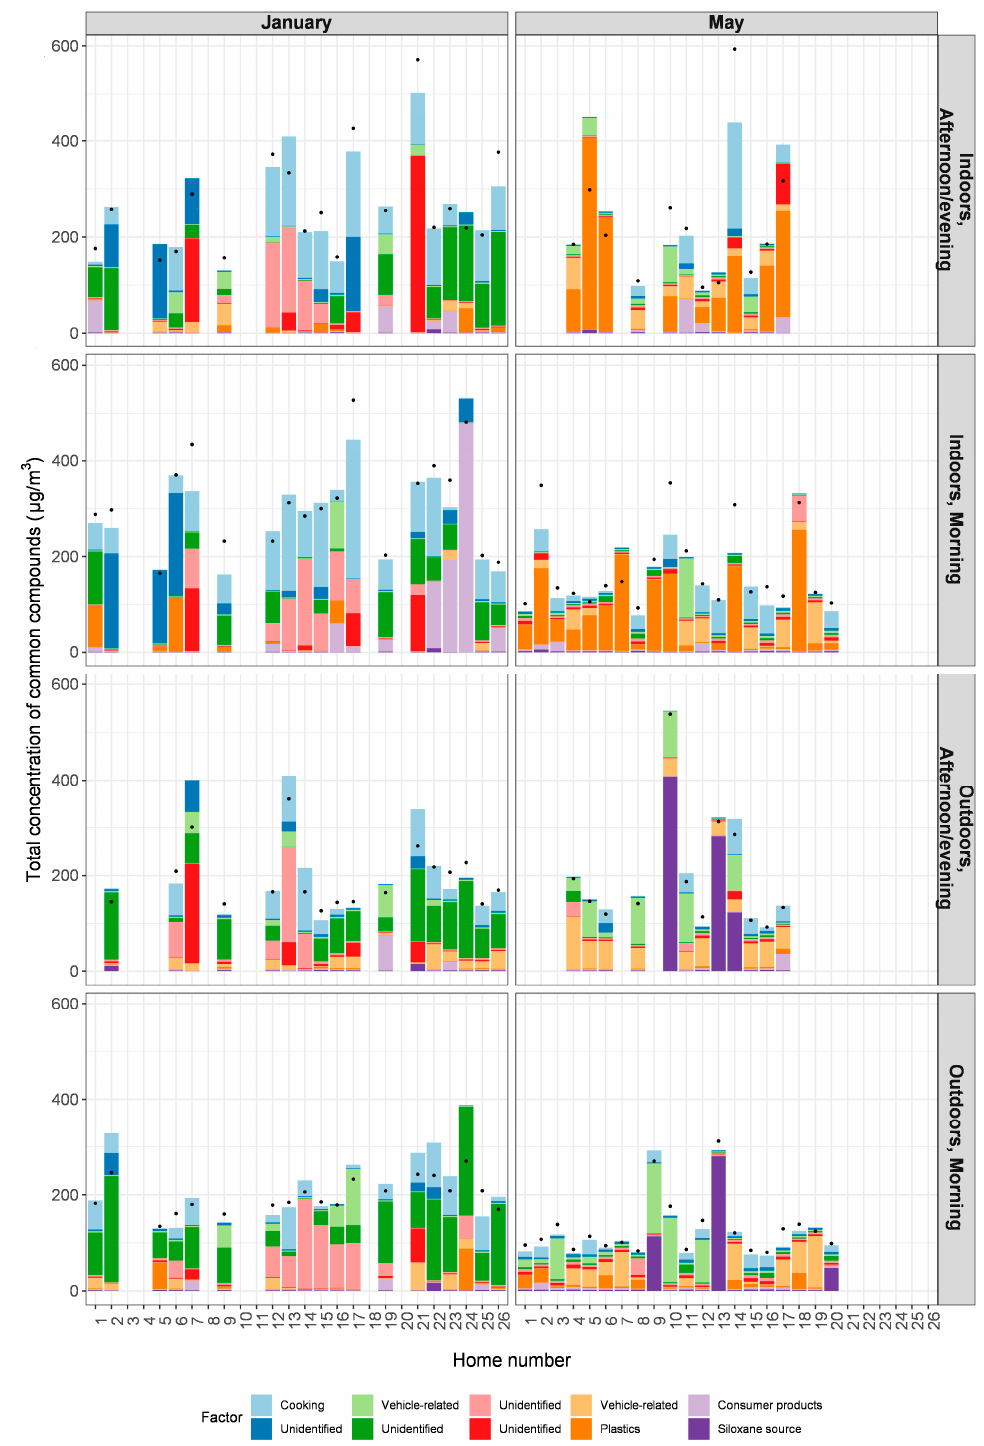
Figure 5. Estimated contributions of each factor to the total sum of species for a sample, with black dots indicating the measured sum of species. Samples ( n = 138) are separated by season (January or May), sampling location (indoors or outdoors) and time of day the sampling occurred (morning, or afternoon/evening). Not all homes had samples for each of these time frames/locations.